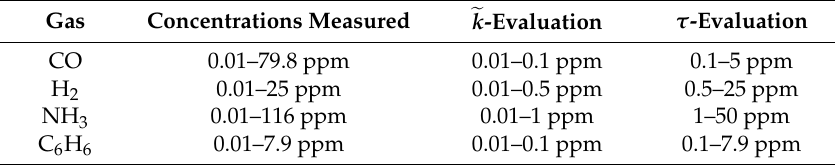
Table 1. Overview of the measured gases, their concentrations and the used quantification method. Gas Concentrations Measured (cid:101) k